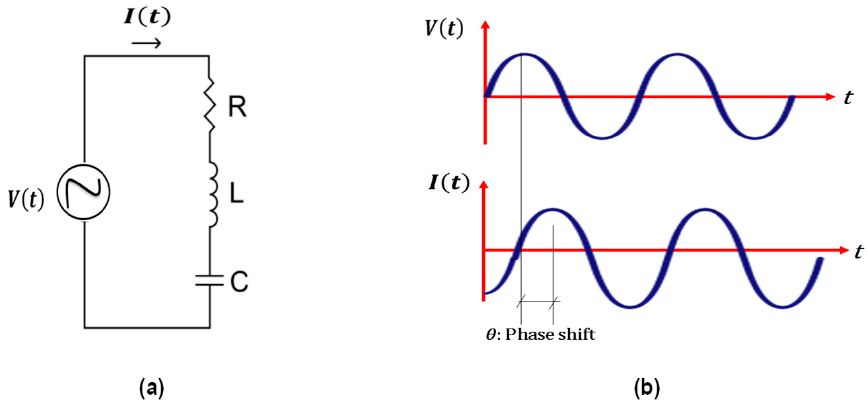
Figure 10. ( a ) a simple AC circuit (RLC) with a resistor, a capacitor, and an inductor in series; ( b ) the phase shift ( 𝜃 = 0 for a resistor; 𝜃 = +90 o for a capacitor; 𝜃 = − 90 o for an inductor). The relationship between the different quantities and the applied perturbation in the time domain can be deduced as illustrated in Equation (4)